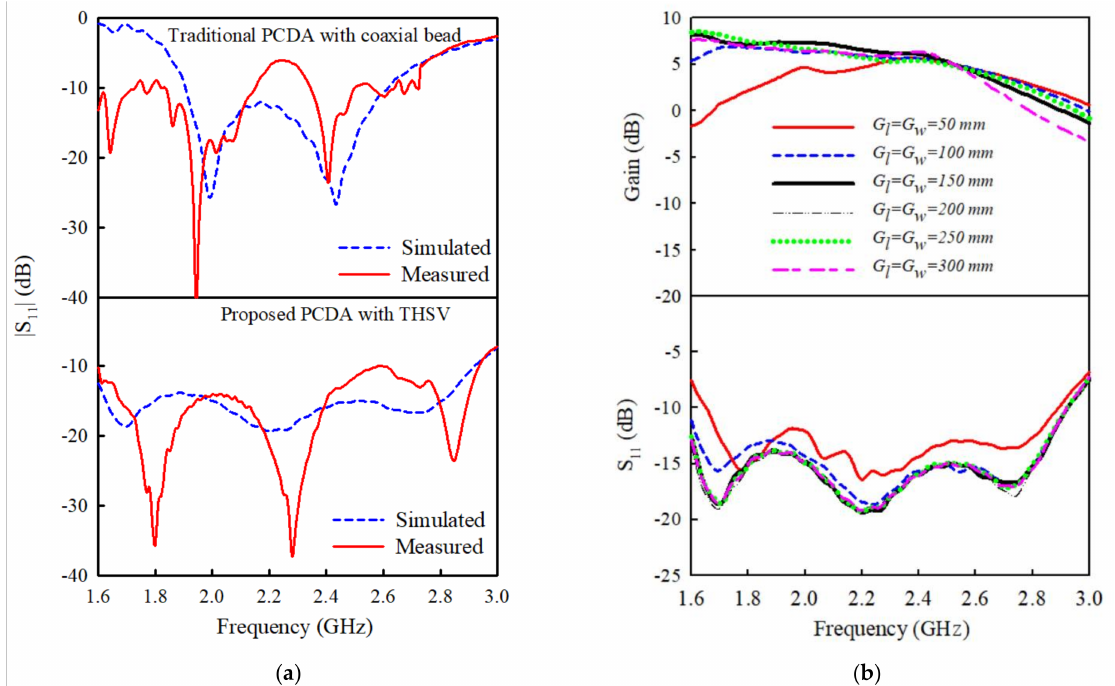
Figure 6. ( a ) Simulated and measured | S 11 | of the PCD antenna with the proposed through-hole signal via (THSV) versus the conventional coaxial bead interconnection; ( b ) Variation of antenna gain and S 11 with reflector ground size ( G l , G w